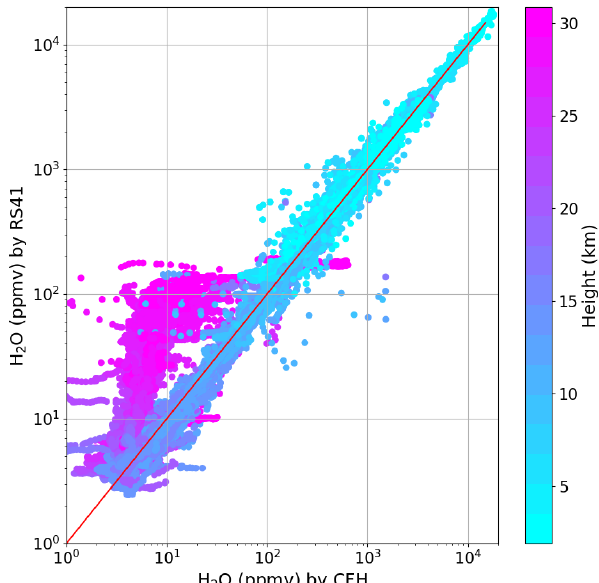
Figure 2. Correlation of water vapor mixing ratios measured si- multaneously by RS41 and the CFH. The color code represents the altitude of the measurement. All data measured by the authors be- tween 2018 and 2020 are